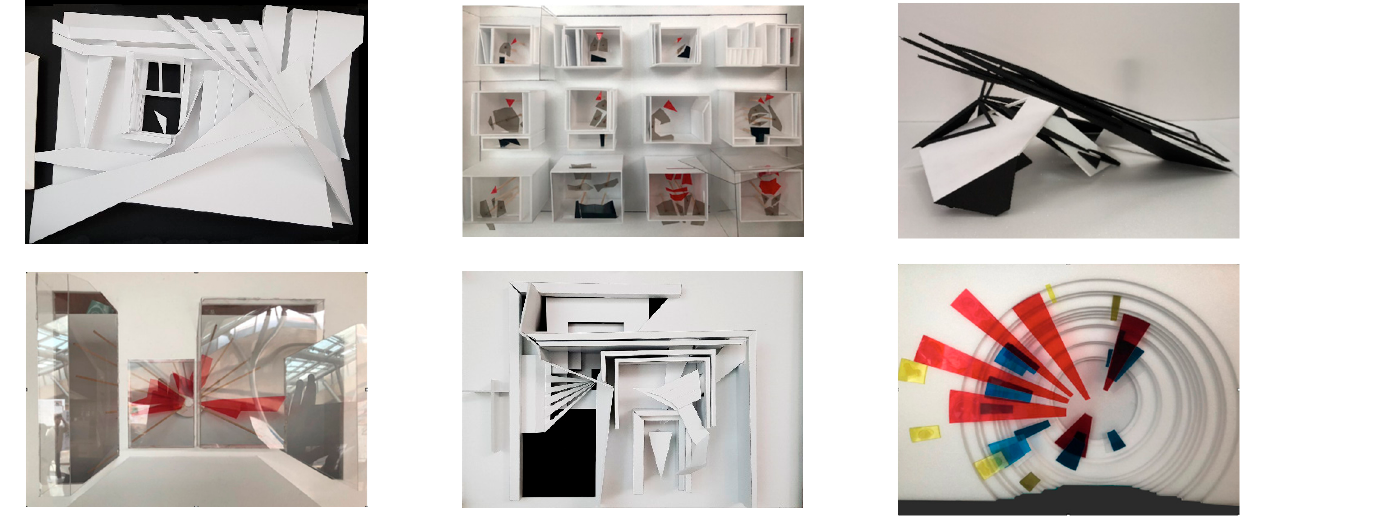
Figure 6. Physical model examples of students’ work.